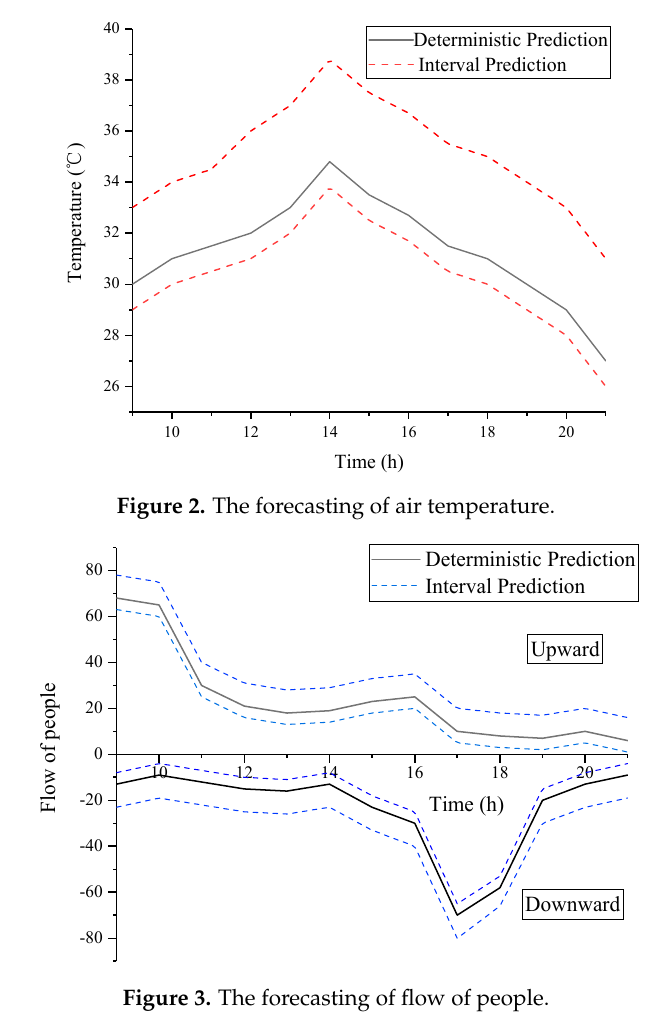
Figure 3. The forecasting of flow of people.